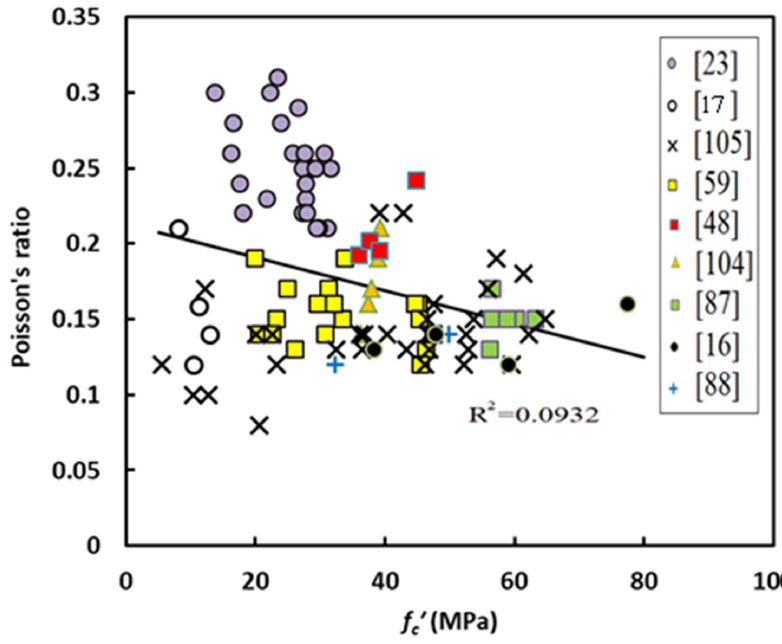
Figure 14. Variation of Poisson’s ratio with compressive strength of GPC.